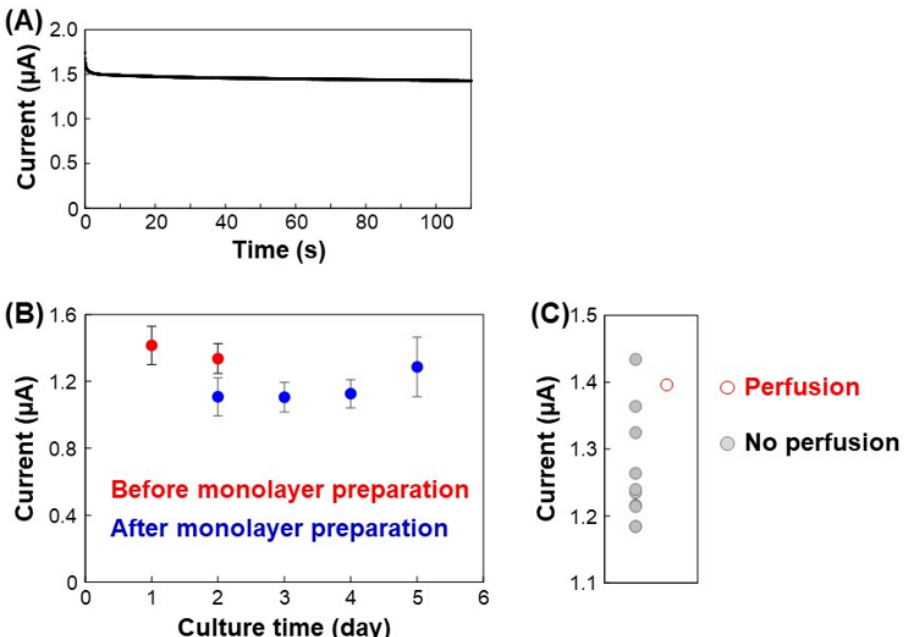
Figure 4. Ion currents at 0.2 V using PBS in Chs. 2 and 4 during the assay. ( A ) Amperogram after 1 d. ( B ) Ion current vs. culture time. The ion currents were obtained from the amperograms at 0.2 V. N = 10. The error bars indicate SDs. ( C ) Ion currents and perfusability after 5 d. The current value of the perfusion sample was higher than those of seven out of the eight samples with no perfusion.